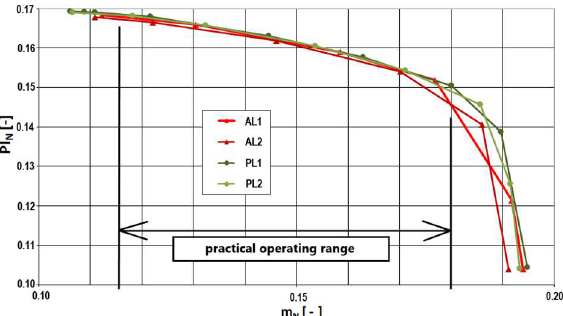
Fig. 10. Measured pressure characteristics of the stage for 13 568 rpm .